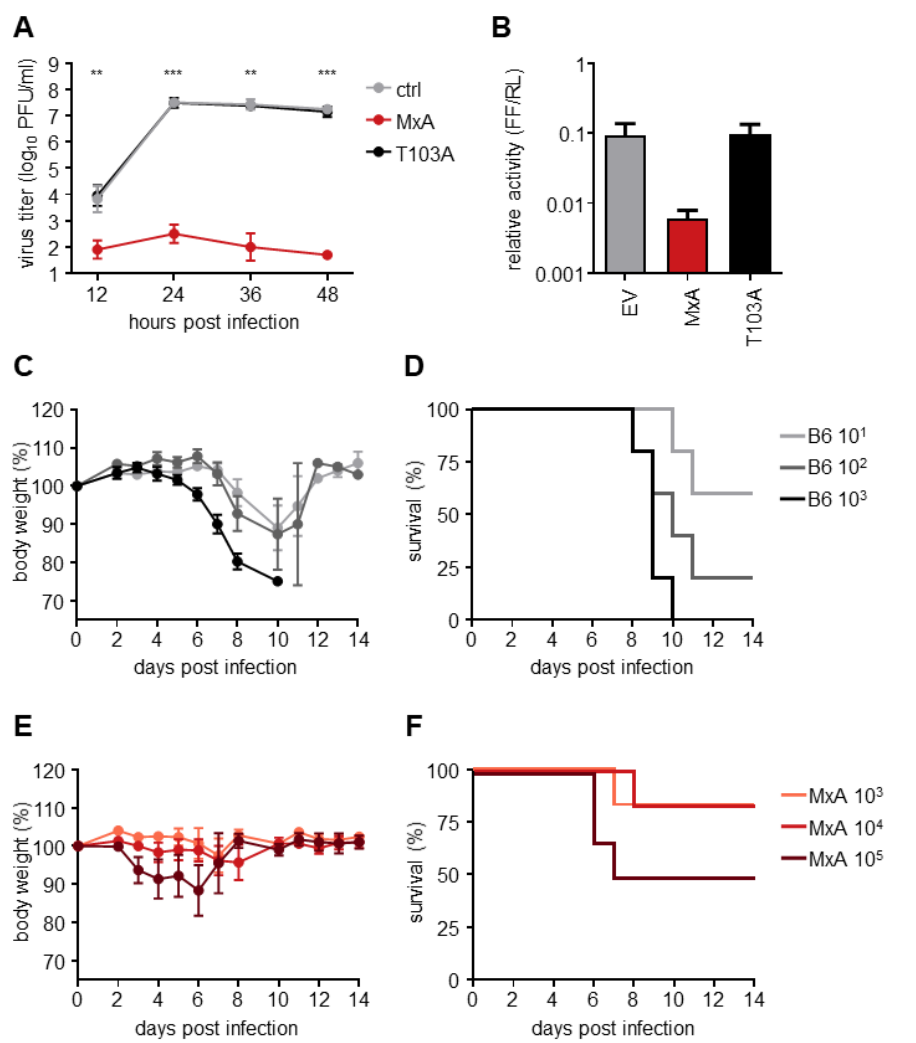
Figure 1. HPAIV H7N9 shows high sensitivity to the antiviral activity of human MxA. ( A ) MDCK- SIAT1 cells (ctrl) and MDCK-SIAT1 cells either expressing antivirally active MxA or inactive MxA- T103A were infected with H7N9 at an MOI of 0.001. Viral titers were determined at the indicated time points via plaque assay. Significance levels indicate differences between MDCK-SIAT1-MxA and -MxA-T103A cells. ( B ) HEK293T cells were co-transfected with expression plasmids coding for the viral polymerase subunits H7N9-PB2, -PB1 and -PA (10 ng each), H7N9-NP (100 ng), an artificial minigenome encoding firefly luciferase as a reporter under the control of the viral promoter (100 ng), and a plasmid encoding Renilla luciferase (30 ng). Constitutive co-expression of Renilla luciferase allows for normalization of transfection efficiency. In addition, expression plasmids encoding either MxA or MxA-T103A (200 ng) or the empty vector (EV) as a control were co-transfected. Luciferase activities were measured 24 h post-transfection. ( C , D ) C57BL/6 (B6) and ( E , F ) MxA tg/tg (MxA) mice (n = 5 each) were intranasally infected with the indicated doses of H7N9 in 40 µL PBS. Bodyweight changes ( C , E ) and survival rates ( D , F ) were monitored for 14 days. Mice were sacrificed once their weight fell below 75% of the initial body weight. Student‘s t test was performed to determine statistical differences. **, p < 0.01; ***, p < 0.001.